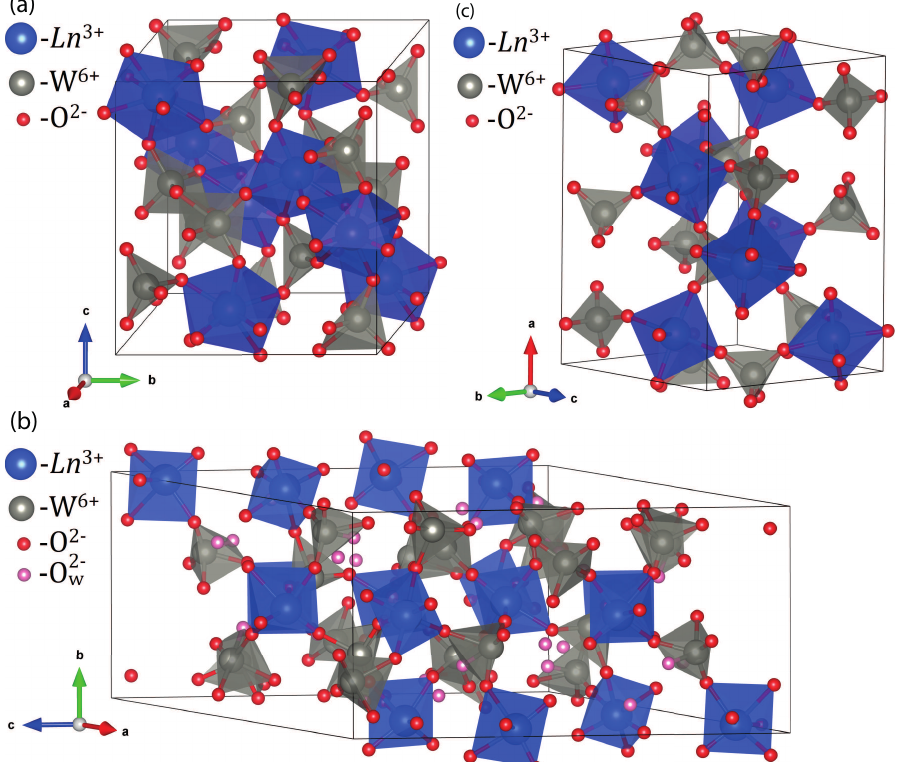
Figure 4. ( a ) Polyhedral representation of the monoclinic structure (sp. gr. C 12/ c 1) encountered as the main phase in lanthanoid tungstates Ln 2 (WO 4 ) 3 ( Ln = Gd, Dy). The lanthanoid Ln 3 + cations are eight-fold coordinated (shown in blue). The W 6 + cations form WO 4 tetrahedra (shown in grey). All the oxide O 2 − anions are shown in red; ( b ) Polyhedral representation of the monoclinic structure (sp. gr. P 12 1 / a 1) encountered as the main phase in lanthanoid tungstates Ln 2 (WO 4 ) 3 ( Ln = Ho, Yb). The lanthanoid Ln 3 + cations are six-fold coordinated (shown in blue). The W 6 + cations form WO 4 tetrahedra (shown in grey). All the oxide O 2 − anions are shown in red. Additional oxygen atoms of hydration H 2 O molecules are shown in pink; ( c ) Polyhedral representation of the orthorhombic structure (sp. gr. Pbcn ) encountered as an admixture phase in Yb 2 (WO 4 ) 3 . The Yb 3 + cations are six-fold coordinated (shown in blue). The W 6 + cations form WO 4 tetrahedra (shown in grey). The oxide O 2 − anions are shown in